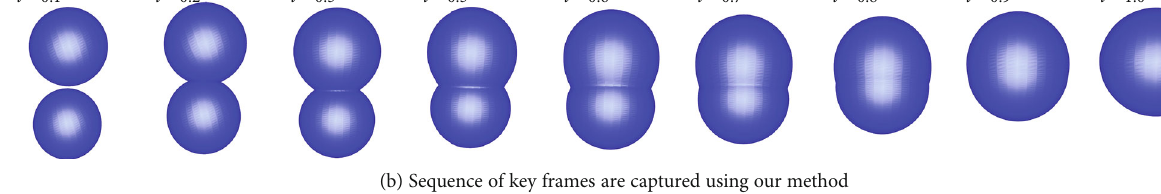
Figure 10: Comparing coalescence process of 3D bubbles in vertical direction to photo (from literatures